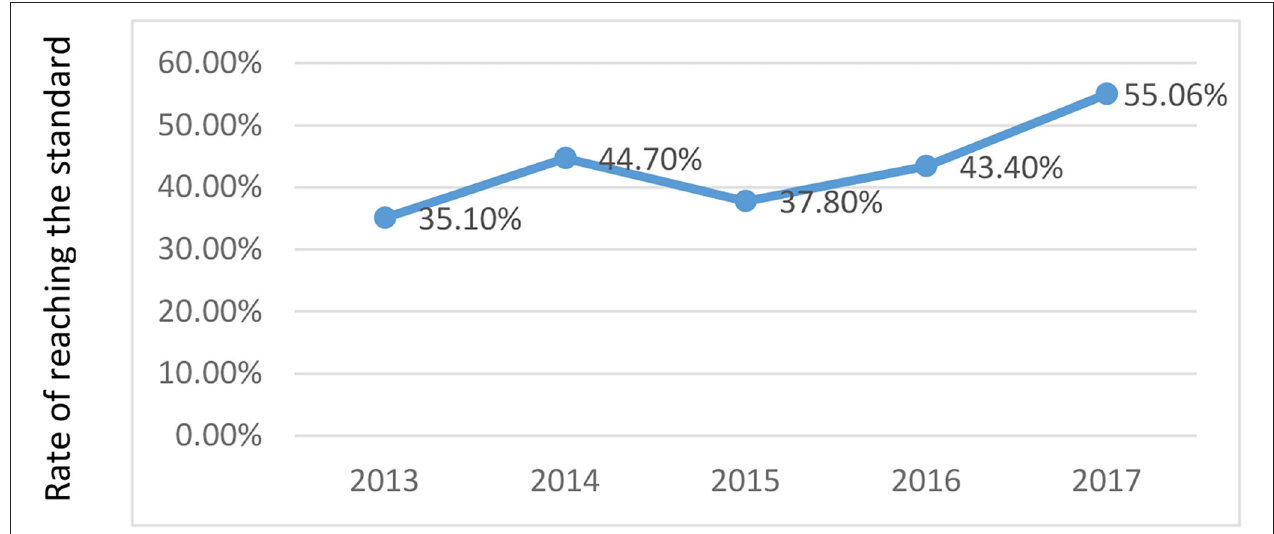
FIGURE 5 | The trend of reaching standard rate of Z City’s air